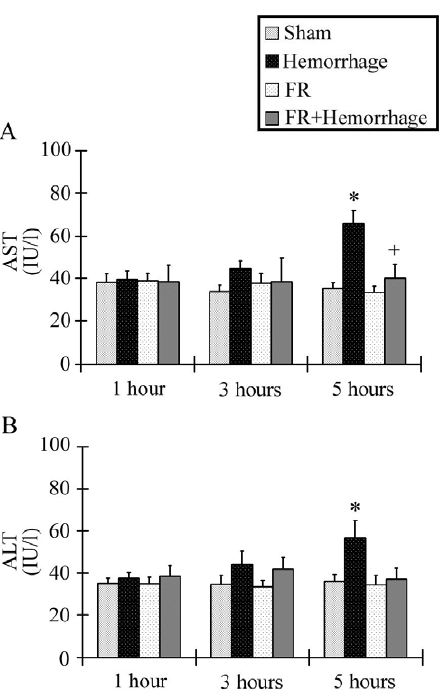
Figure 7. Changes in serum AST and ALT levels. The levels of liver enzymes in the Hemorrhage group increased with time and were significantly higher than in the Sham group at 5 hours after hemorrhage. Administration of FR167653 (FR + Hemorrhage group) inhibited the increase AST and ALT (A and B respectively). Data are shown as mean 6 SE. n=5/groups, * p , 0.05 vs Sham, + p , 0.05 between Hemorrhage and FR + Hemorrhage.